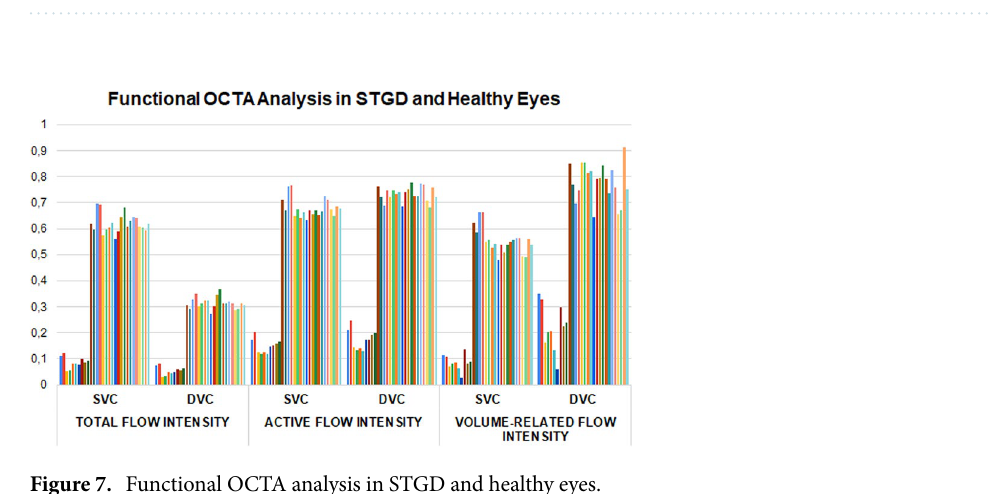
Table 1. Clinical Data and OCTA Quantitative Metrics in STGD and Healthy Subjects. SVC superficial vascular complex, DVC deep vascular complex, TFI total flow intensity, AFI active flow intensity, VFI volume- related flow intensity, VD vessel density.